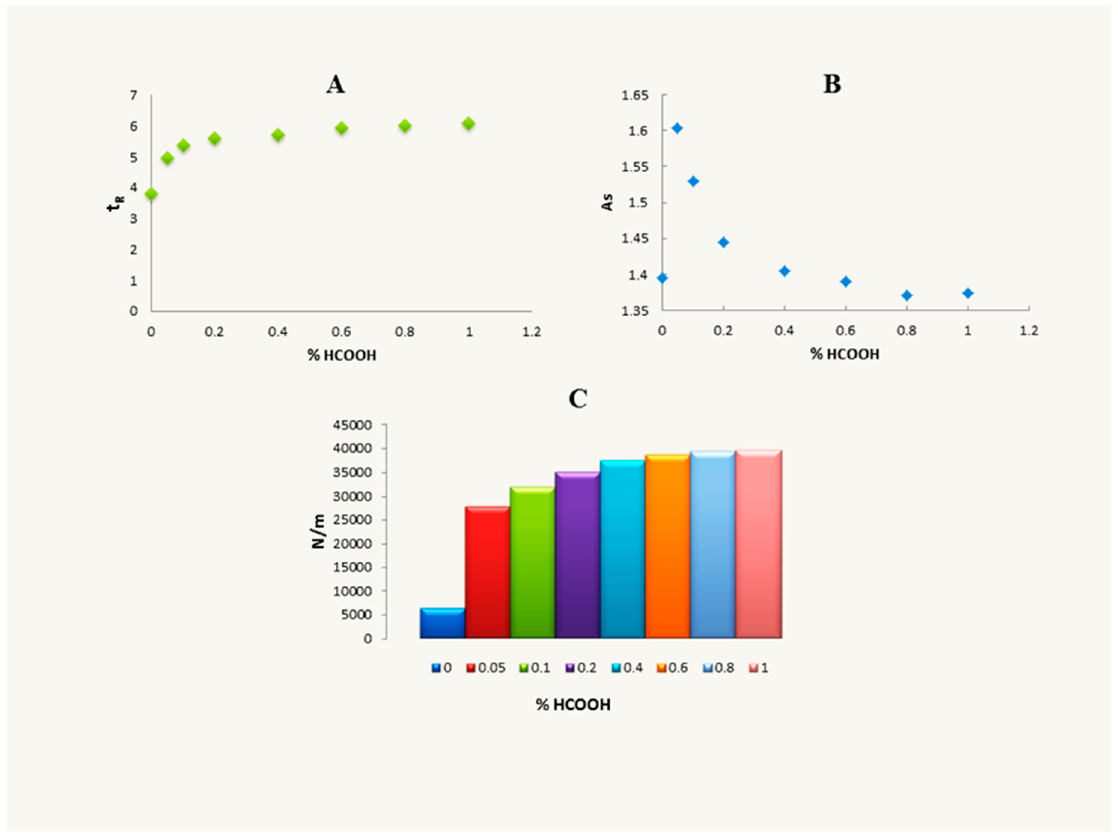
Figure 4. Relationship between formic acid concentration and retention time (t R ) ( A ), asymmetry factor (As) ( B ) and system efficiency (N/m) ( C ). Data was obtained for cytisine standard (10 μ g/mL) using Synergi 4 μ m Polar-RP 80 Å column with mobile phase containing H 2 O and HCOOH.